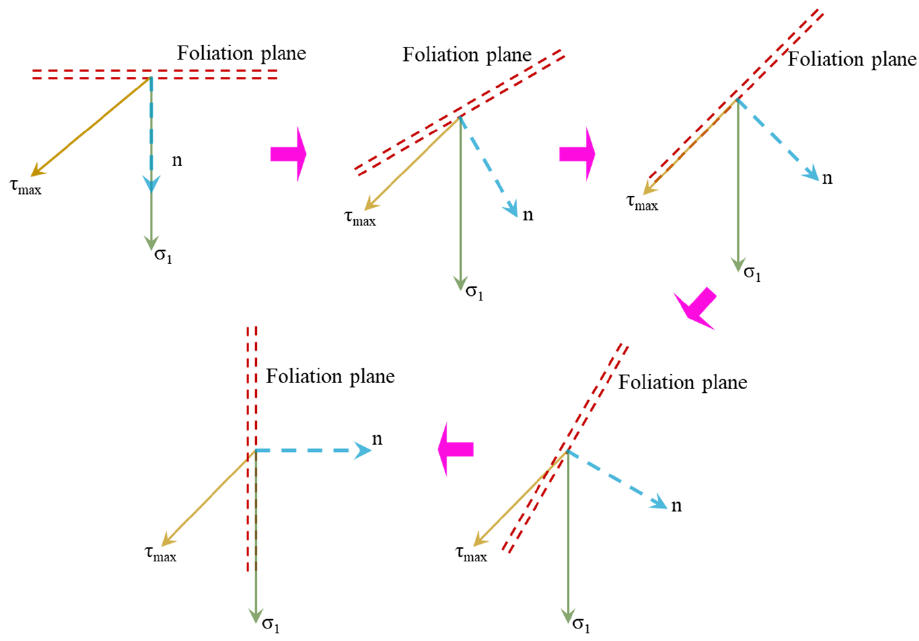
Figure 14. Failure mechanism analysis of foliated phyllite under uniaxial compression.